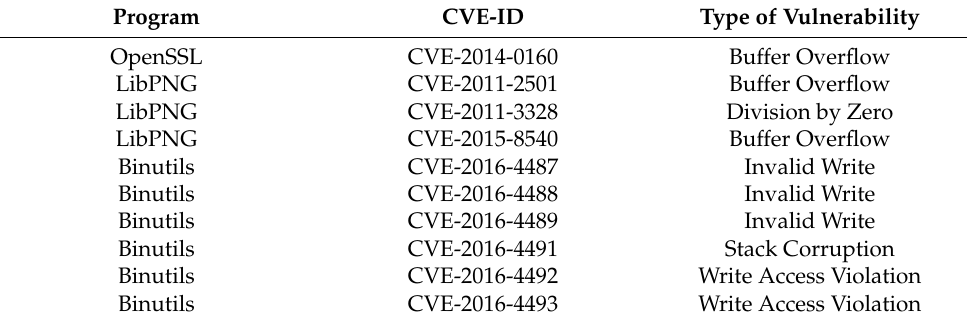
Table 4. CVE vulnerabilities utilized in